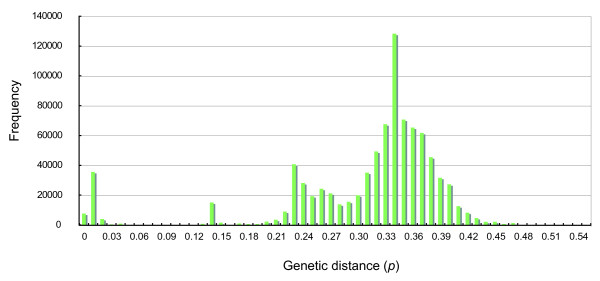
Mismatch distributions of the pairwise genetic distances for the 1,336 mitochondrial COI sequences. A total of 891,780 frequencies calculated from the 1,336 sequences are plotted in the figure.